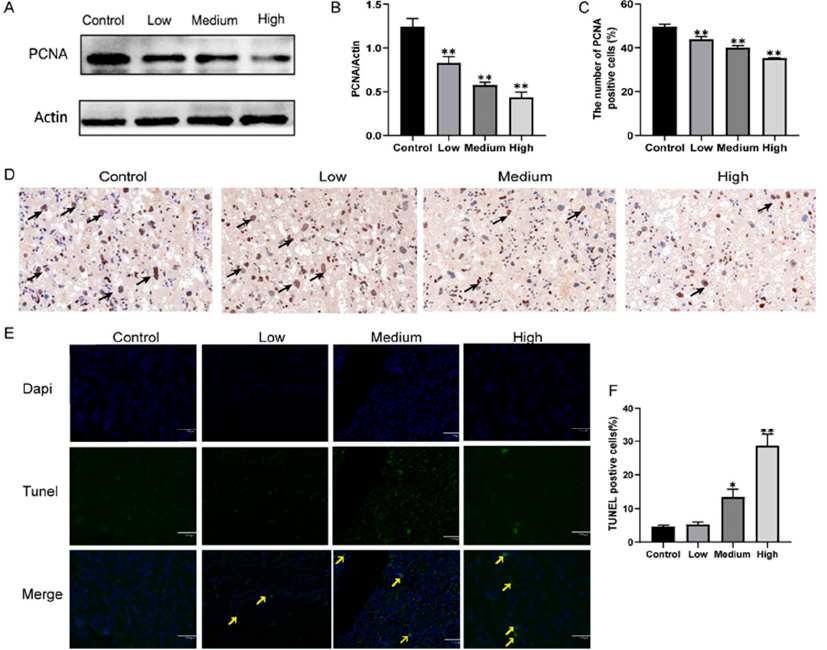
Figure 5. Effects of gestational cyfluthrin exposure on cell proliferation and apoptosis in the placenta. Pregnant rats were administered corn oil or different doses of cyfluthrin (6.25, 12.5, or 25 mg/kg) daily in pregnancy. Rat placentas were collected on GD19. ( A ) Western blot image of PCNA expression. ( B ) Expression levels of PCNA protein. ( C ) Rate of PCNA-positive cells in the labyrinthine region. ( D ) Placenta section was immunohistochemically stained with PCNA. Arrows indicate PCNA-positive cells in the labyrinthine region. Original magnification: 40×. ( E ) TUNEL-labeled placental tissues. Yellow arrows: TUNEL-positive cells. Scale bars = 170 μ m. ( F ) The percentage of TUNEL-positive cells. Values are expressed as the mean ± SE. The result was analyzed with one-way ANOVA followed by Dunnet’s t -test. * P < 0.05, ** P < 0.01 compared to controls.